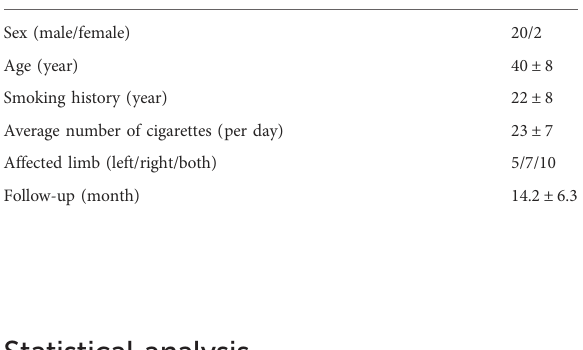
TABLE 2 Basic information of the patient.